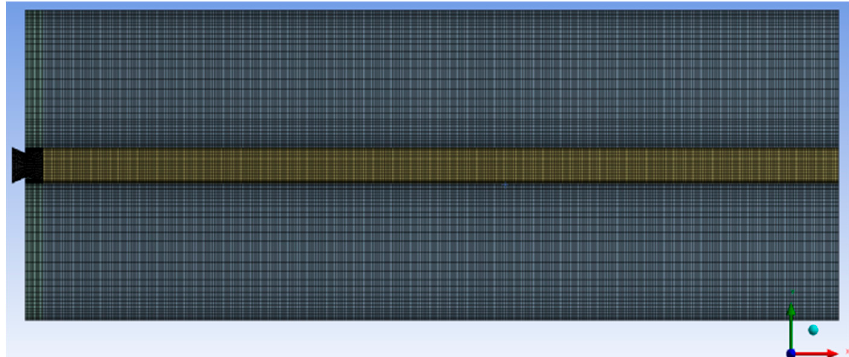
Figure 3. Hexahedral meshing of the computational domain.